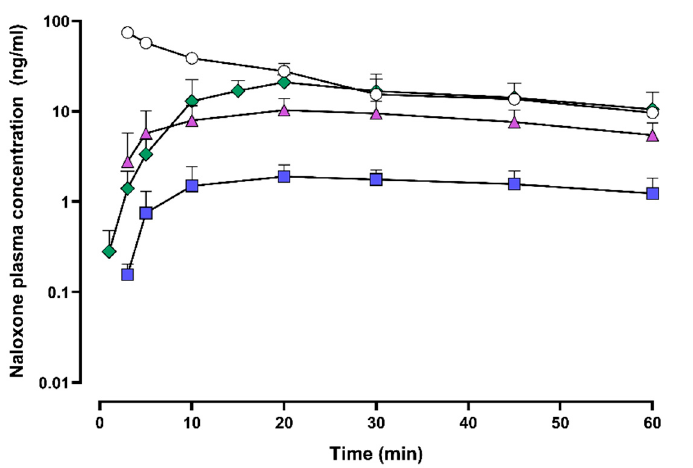
Figure 1. Naloxone plasma concentrations after intravenous administration and after ocular administration. Upper panel: naloxone plasma concentrations during the first 8 h after administration; lower panel: during the first hour after administration. Mean + standard deviation are shown. Four dogs received naloxone intravenously and six as eye drops. i.v., intravenous. Table 1. Pharmacokinetic parameters of naloxone after intravenous and ocular administration. Dosing Route